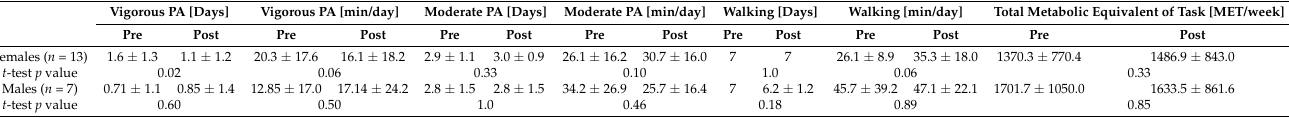
Table 3. Physical activity levels in Tourism and Recreation students in a 14-week period of the COVID-19 pandemic. Data are presented as mean value ± standard